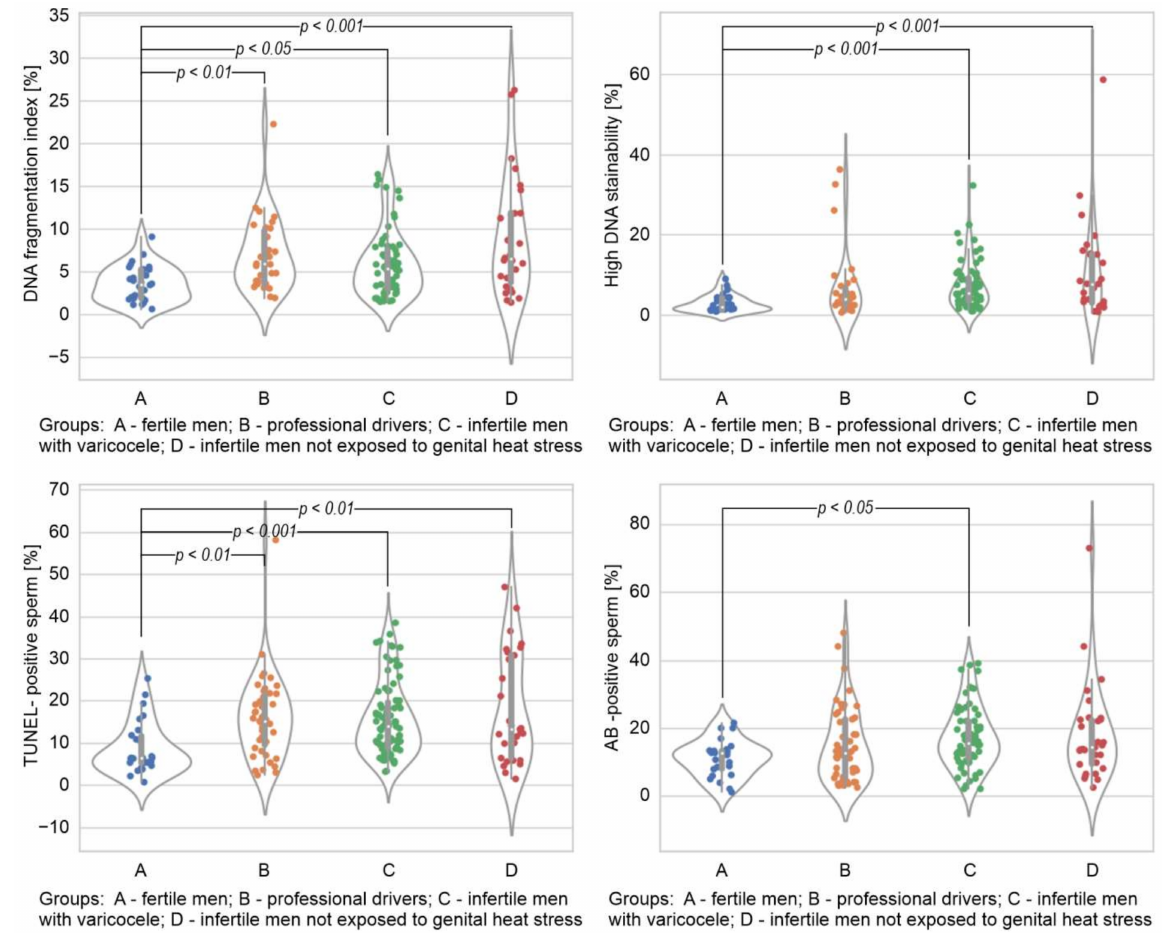
Figure 1. Comparison of sperm DNA fragmentation index, high DNA stainability index, and the percentage of TUNEL-positive and AB-positive sperm among the studied groups. The results are expressed as the median, Q1–Q3, and range. p < 0.05, p < 0.01, p < 0.001 calculated using the Dunn test with Holm’s correction compared to the control